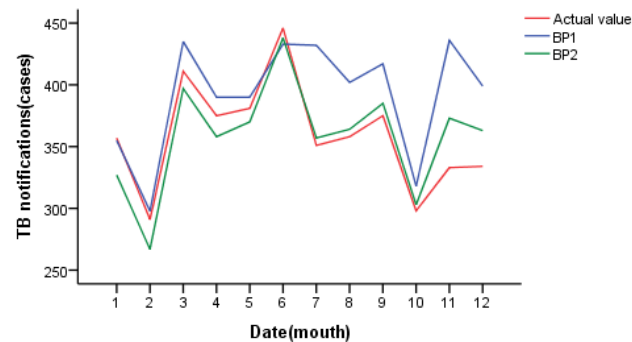
Figure 9. Prediction results of BP neural network (by monthly statistics).